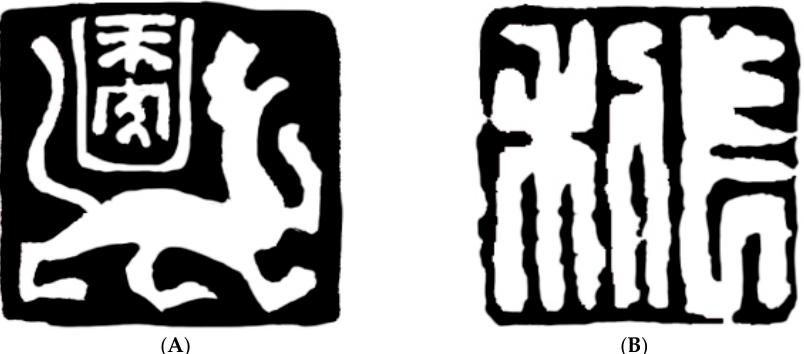
Figure 5. ( A ) A Jiyuyin with Chinese characters “Weiyang” and a tiger motif. The Han Dynasty. Inventory number: 0509. Sketched by author. Picture source: Wen (1995), p. 164. The original collection: Chen, Jieqi. Fu Zhai Gu Yin Ji [ 《簠齋古印集》 ]. Shanghai: Shenzhou Guoguang Society, 1936. ( B ) A Jiyuyin with Chinese characters “Changli 長利 ”. The Han Dynasty. Sketched by author. Picture source: Li (2012), p. 72.